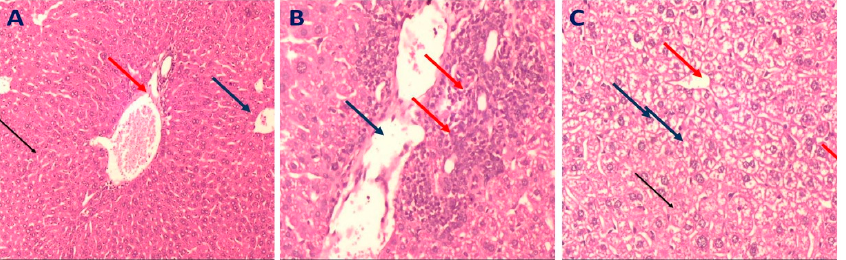
Figure 6. Representative photomicrograph of a liver section of mice groups (H&E, × 200) as follows: ( A ); normal control group: displayed portal tract formed of the portal venule, portal arteriole, and bile ductile (red arrows), normal sized central veins (blue arrows) surrounded by normal sized cords of hepatocytes (black arrows). ( B ); diseased group: showed central veins (red arrows) surrounded by hepatocytes with marked steatosis (blue arrows) and marked in fl ammation, while other cells showed individual cell necrosis. ( C ); simvastatin mice group: liver sections of mice received simvastatin (10 mg/kg) showed portal tract surrounded by mild in fl ammatory cellular in fi ltrate (red arrow) and hepatocytes with mild steatosis (blue arrow).